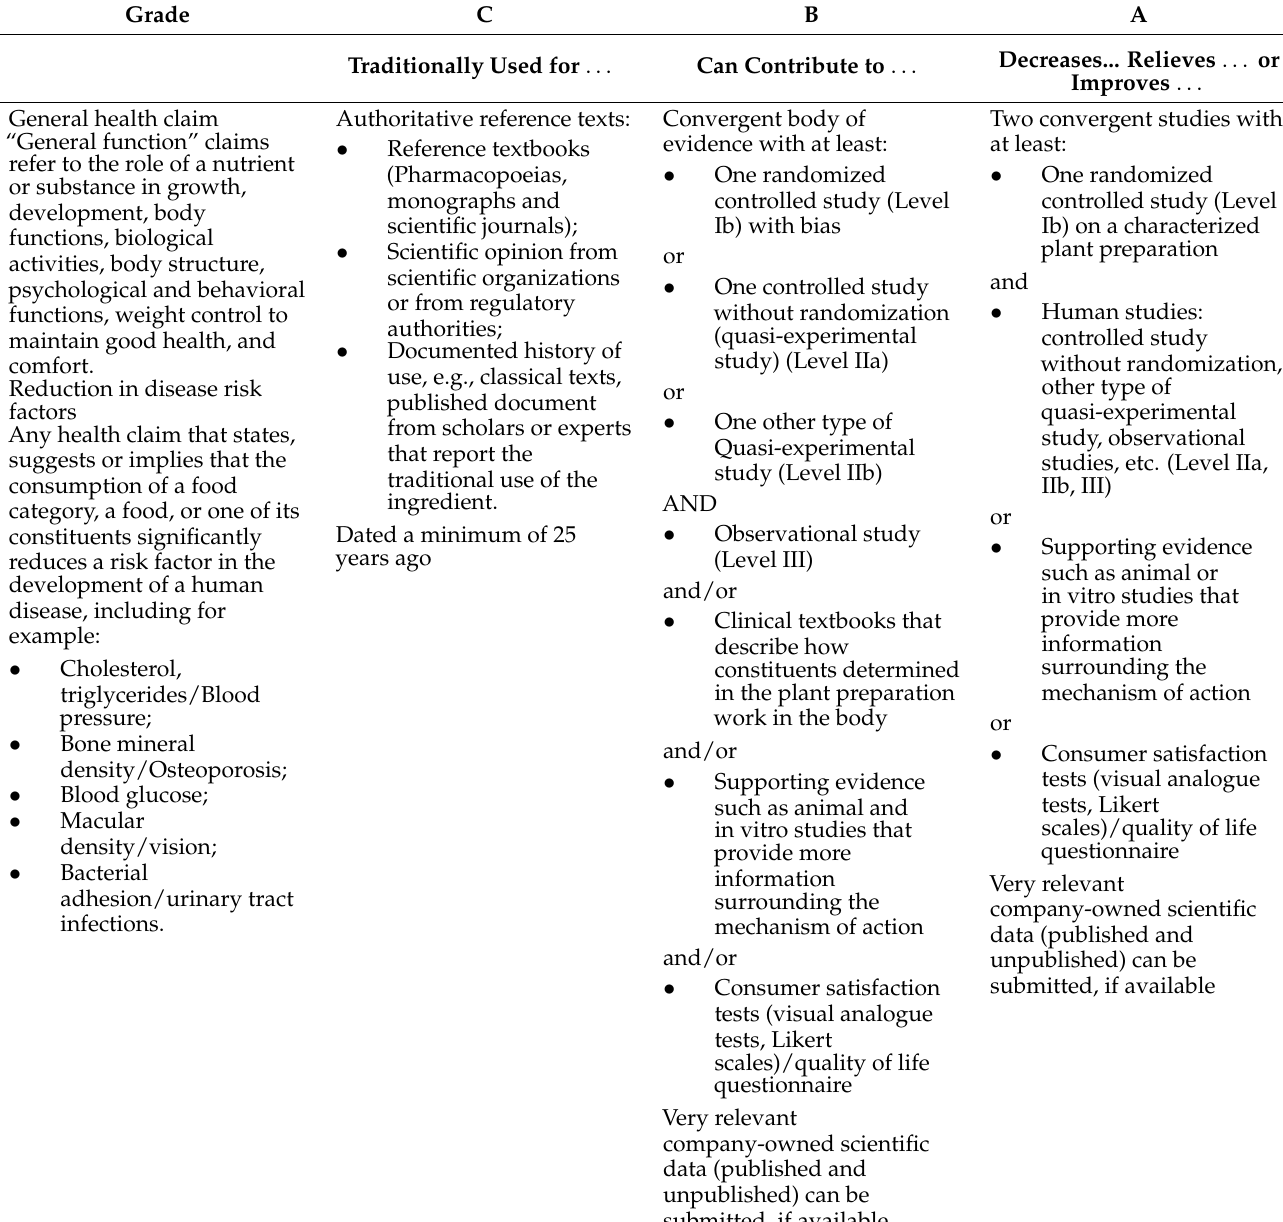
Table 1. Synadiet’s model proposal for botanical health claim evaluations. Grade C B A Traditionally Used for . . . Can Contribute to . . .